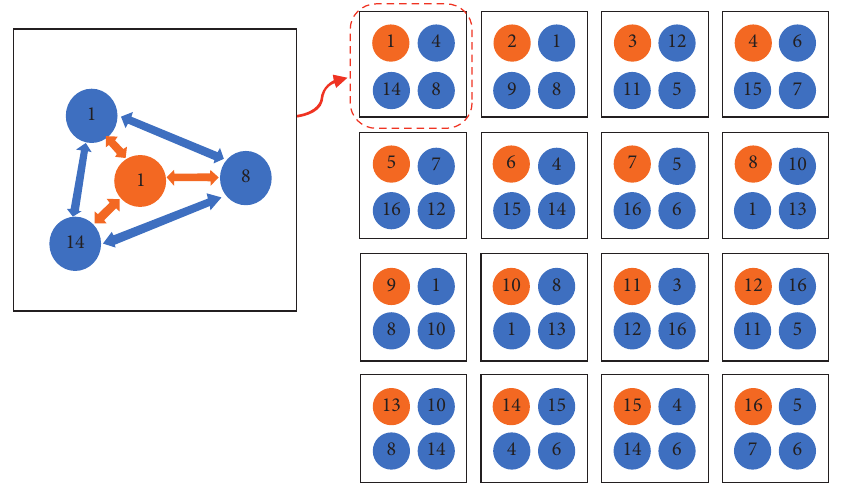
Figure 5: Results of similarity